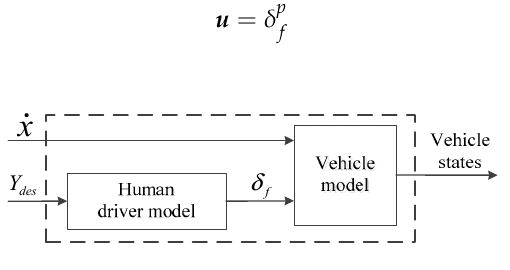
Figure 2. Structure of the driver-vehicle system.